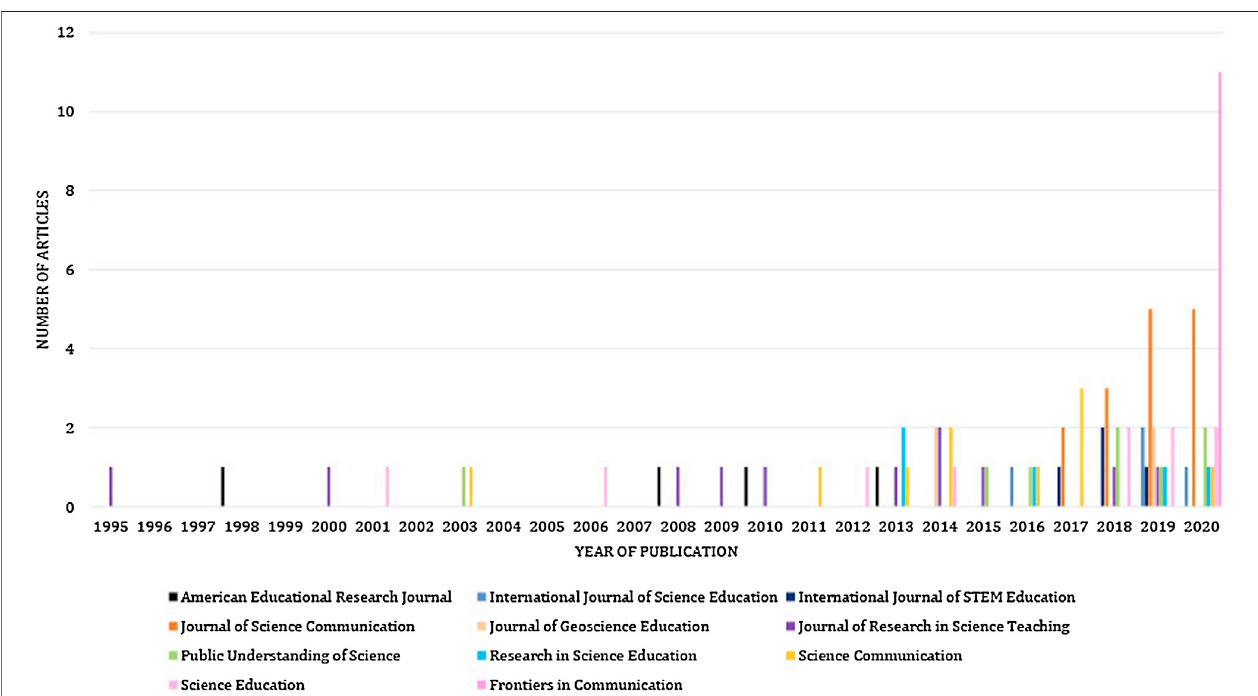
FIGURE 3 | Journals with four or more inclusion focused articles published. Although the sample timeframe spans 1980 – 2020, all of the articles in the top publishing journals were published from 1995 onwards, therefore this graph shows only 1995 – 2020.